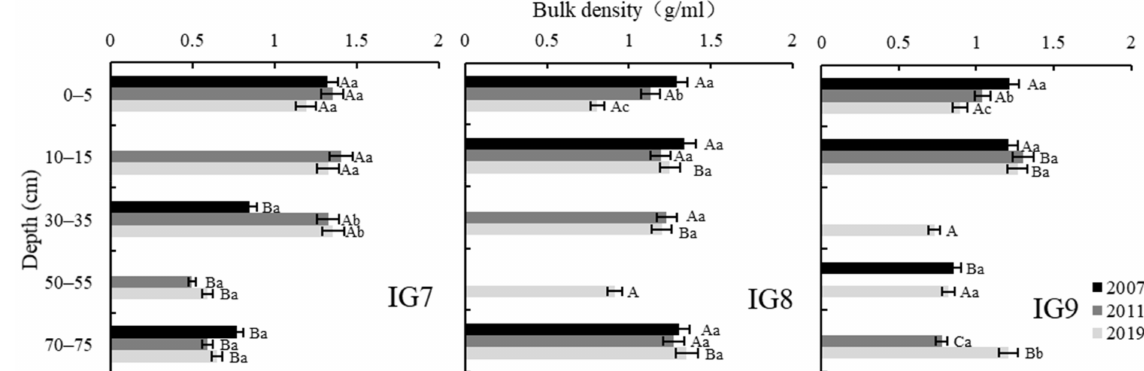
Figure 2. Bulk density at the different sites; different lowercase letters express significant difference at the same depth (one-way ANOVA, p < 0.05), and different uppercase letters express significant difference under different soil depths (one-way ANOVA, p <